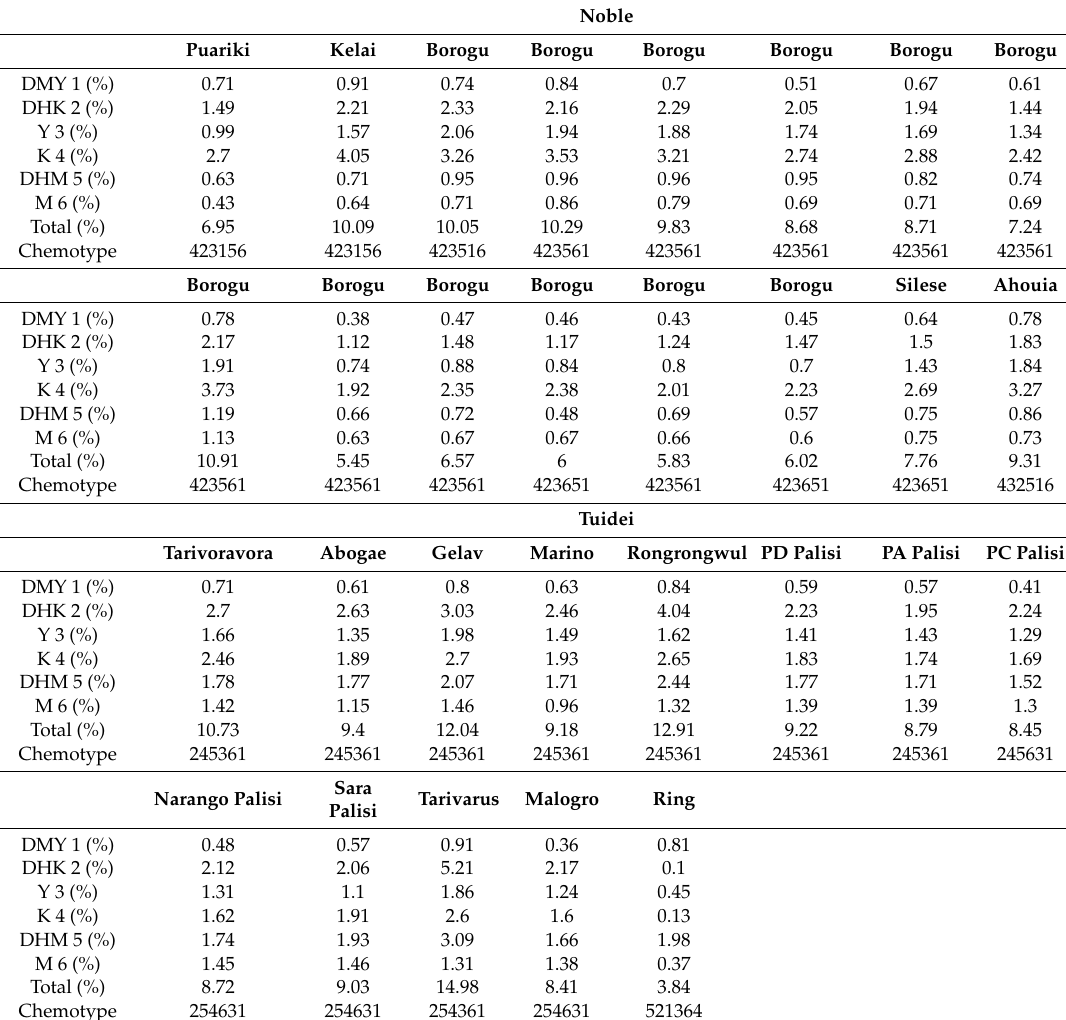
Table 2. Chemotypes and kavalactone quantities of noble and tuidei kava